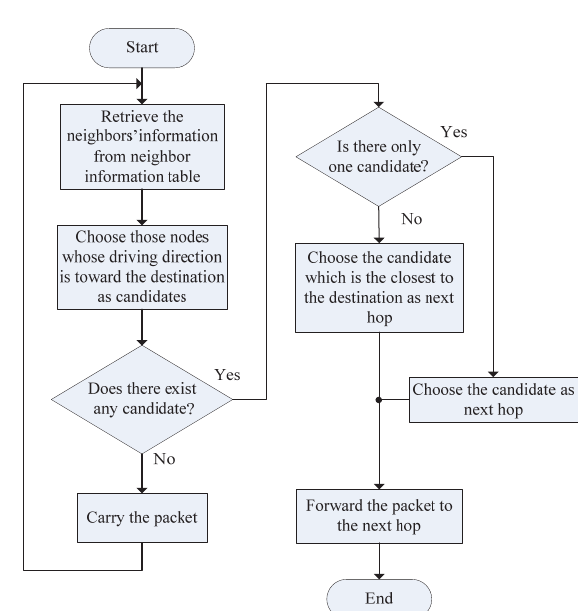
Figure 4. An overview of the straightway mode